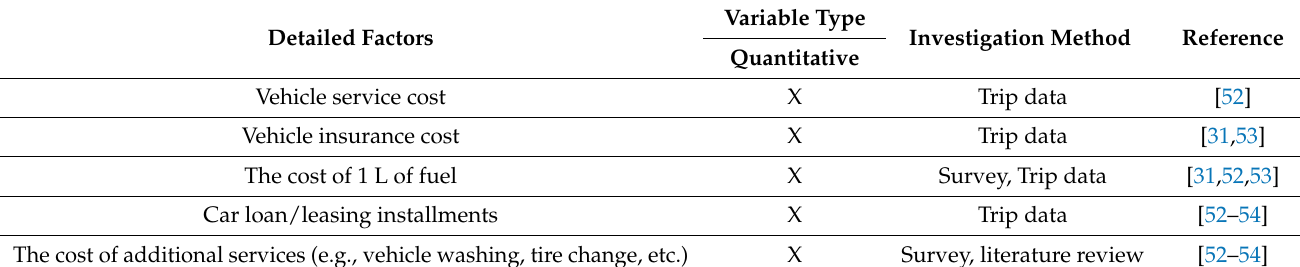
Table 3. Costs of maintaining an individual vehicle.